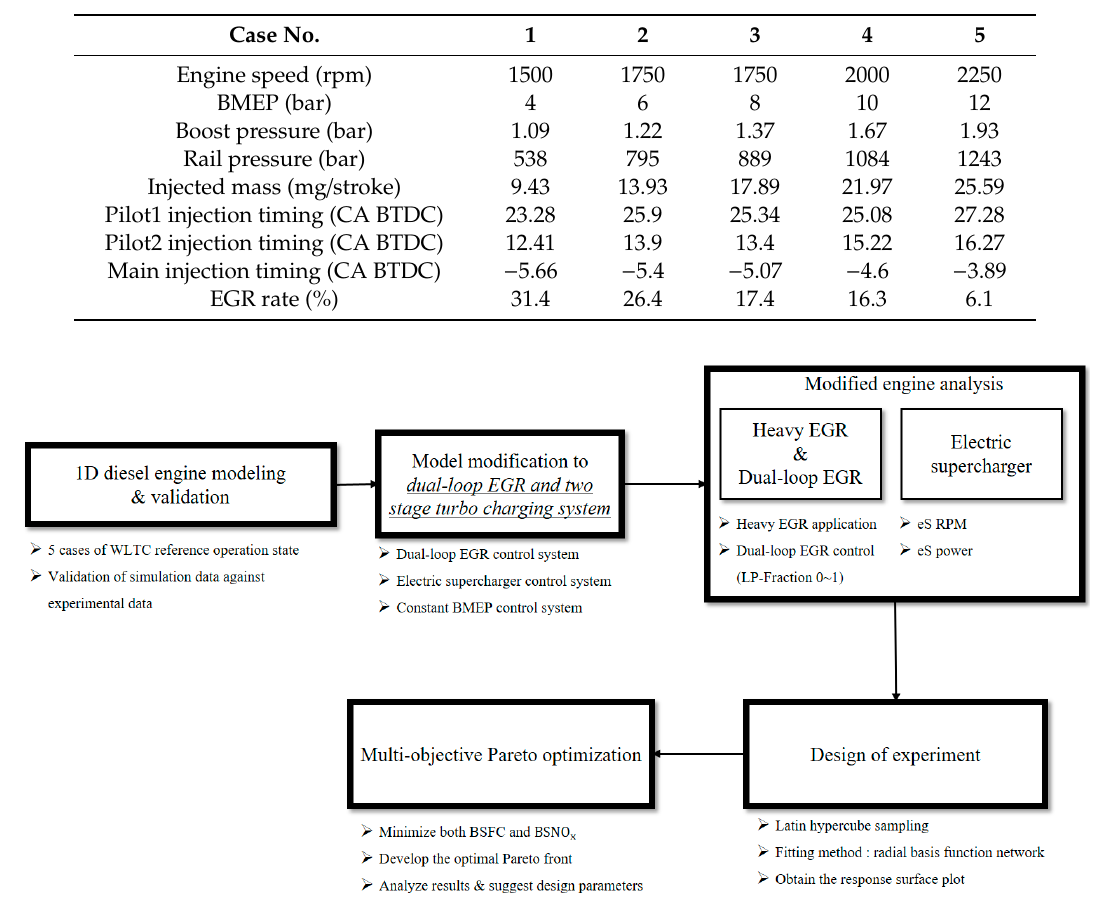
Table 3. Detailed operating conditions of the selected WLTP reference points.